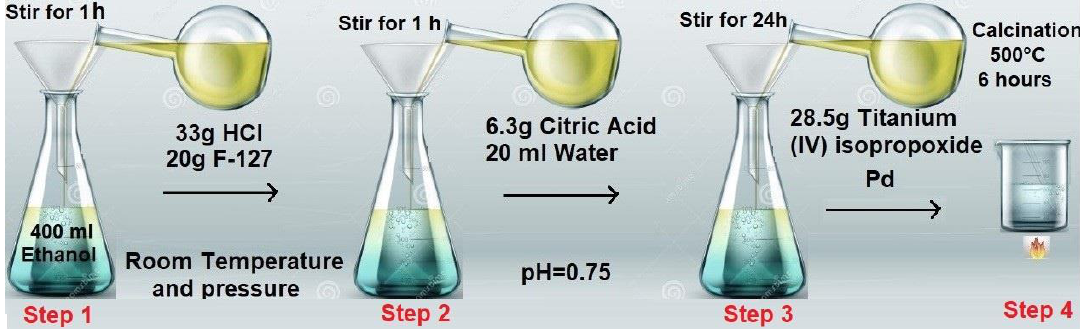
Figure 14. Photocatalyst preparation process describing the four steps considered for Pd-doped